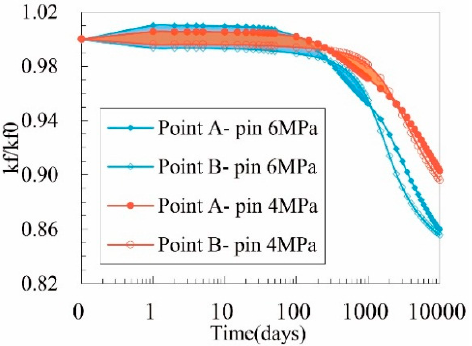
Figure 16. Evolution of fracture permeability at different points under the 4 MPa and 6 MPa injection pressure.